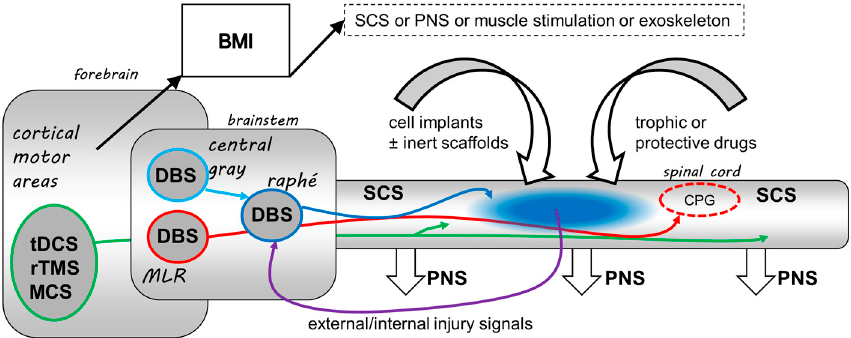
Figure 1. Diagram of possible sites for therapeutic electrical stimulation and other common interventions in spinal cord injury (SCI). Deep brain stimulation (DBS) of a brainstem restorative feedback loop is proposed to augment restorative effects around the injury site. This treatment resembles cell implantation or drug treatments in that it aims for non-specific recovery of visceral and sensory-motor deficits. Most forms of stimulation are concerned with narrowly specified functions. Thus DBS in brainstem central grey may also be used to block neuropathic pain. The nearby mesencephalic locomotor region (MLR) can be stimulated to activate descending pathways that boost the locomotor central pattern generator (CPG) in lower thoracic and upper lumbar segments. Cortical stimulation activating corticospinal tracts, whether non-invasively via transcutaneous direct current stimulation (tDCS) or repetitive transcranial magnetic stimulation (rTMS), or invasively with direct motor cortex stimulation (MCS), can be used for immediate production of movement or to induce adaptive plastic changes in motor output. Cortical commands may also be fed to a brain-machine interface (BMI) to control variously situated electrodes for peripheral nerve stimulation (PNS) or spinal cord stimulation (SCS). SCS distal to the injury has been used for bladder control; proximal SCS can be used block pain; and stimulation at any spinal location can be used to generate movements, depending on the degree of completeness of functional loss. The simplicity and comprehensiveness of restorative DBS in the brainstem are points in its favour.